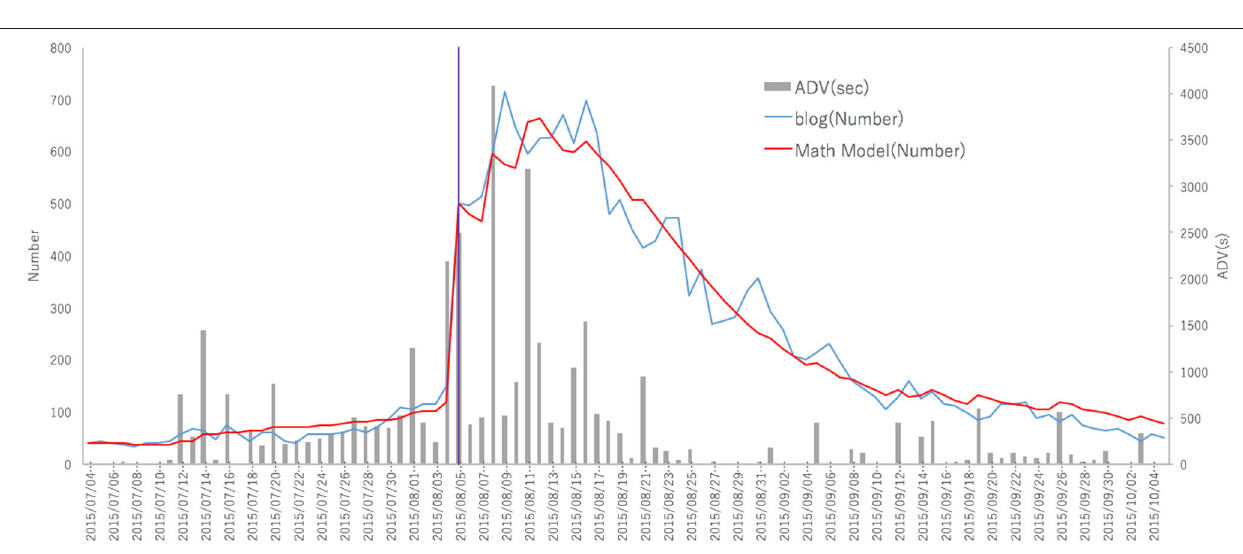
Frontiers in Physics |